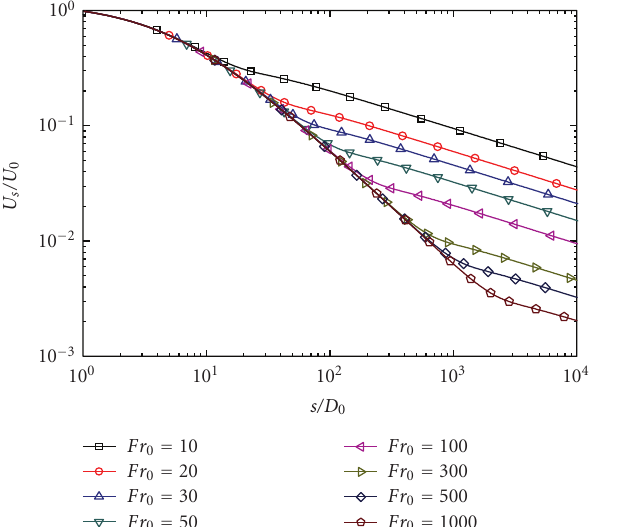
Figure 6: Velocity decay of horizontal buoyant jet.